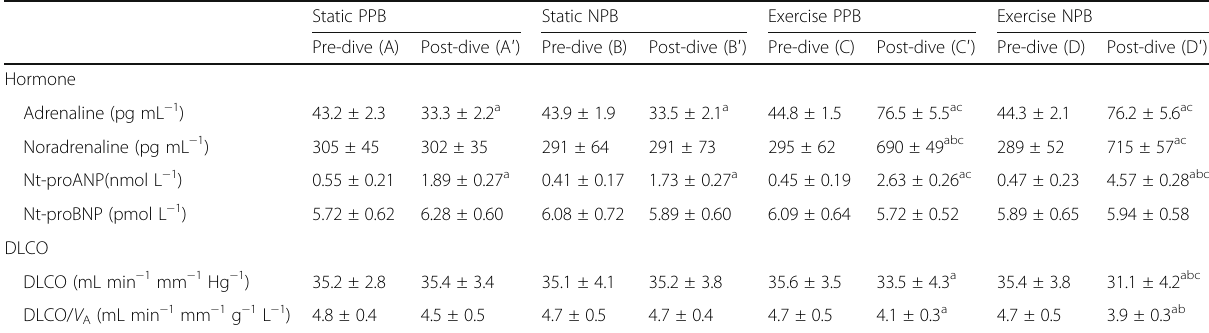
Table 3 Plasma concentrations of Nt-proANP, Nt-proBNP, adrenaline, and noradrenaline before and after